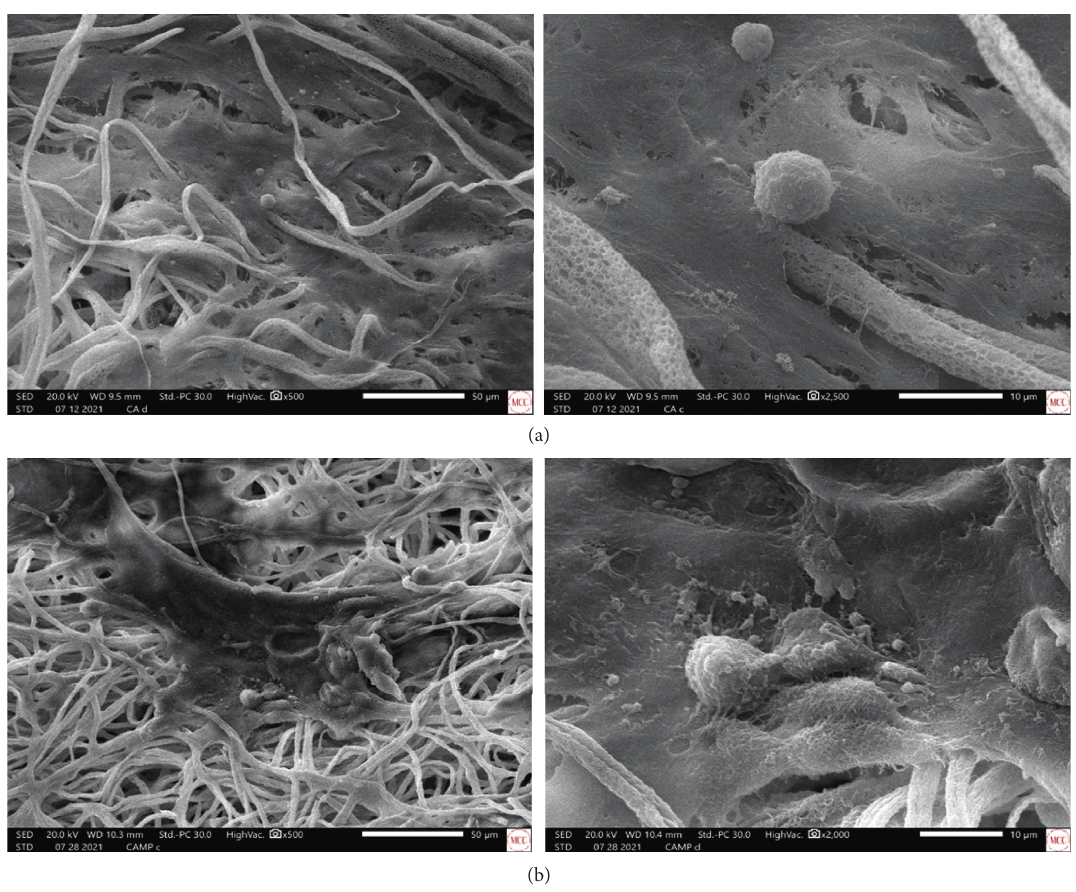
Figure 8: SEM images of hFOB 1.19 cells on (a) CA and (b) CA-MP fiber mats after 14 days of